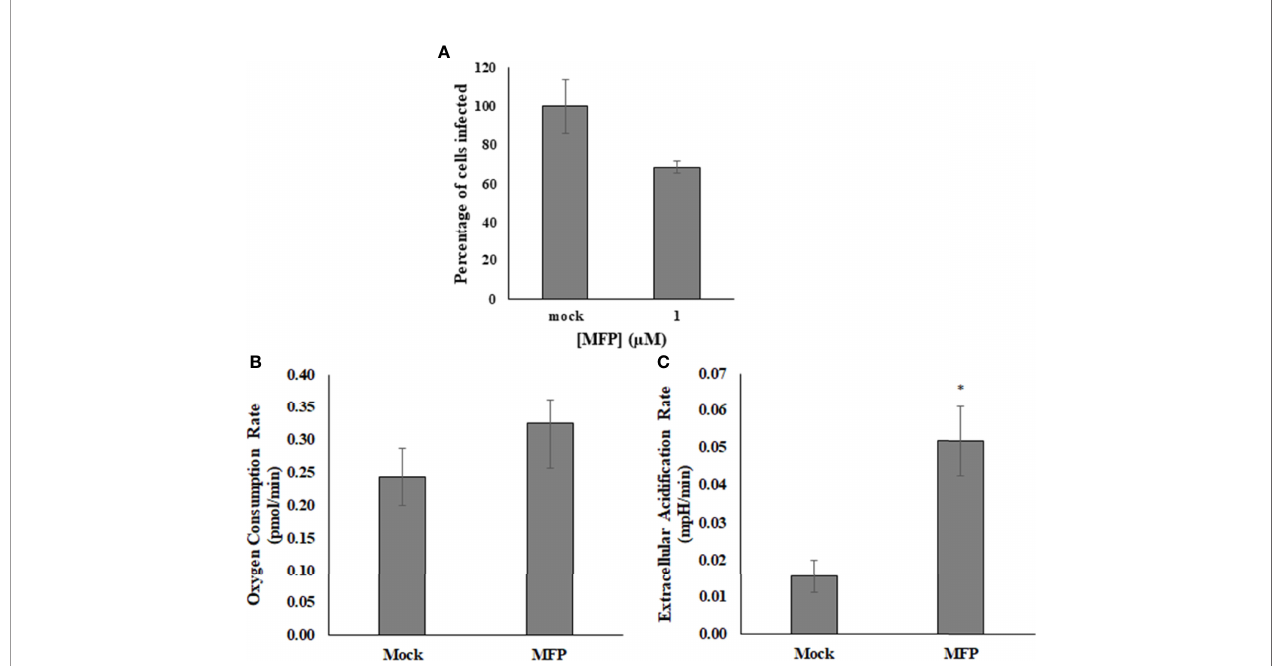
FIGURE 6 | M1/MFP did not show any antiviral activity, but altered the host cell metabolism when used at a concentration of 100 µM. When used as a treatment for SINV (MOI=1), there was no signi fi cant alteration to viral output (A) . The OCR and ECAR readings were determined at a concentration of 100uM MFP in uninfected cells. There is no signi fi cant different in the oxygen consumption rate, p = 0.3 (B) , but the extracellular acidi fi cation rate is signi fi cantly different from the mock, untreated sample, p = 0.005 (C) . Mock=